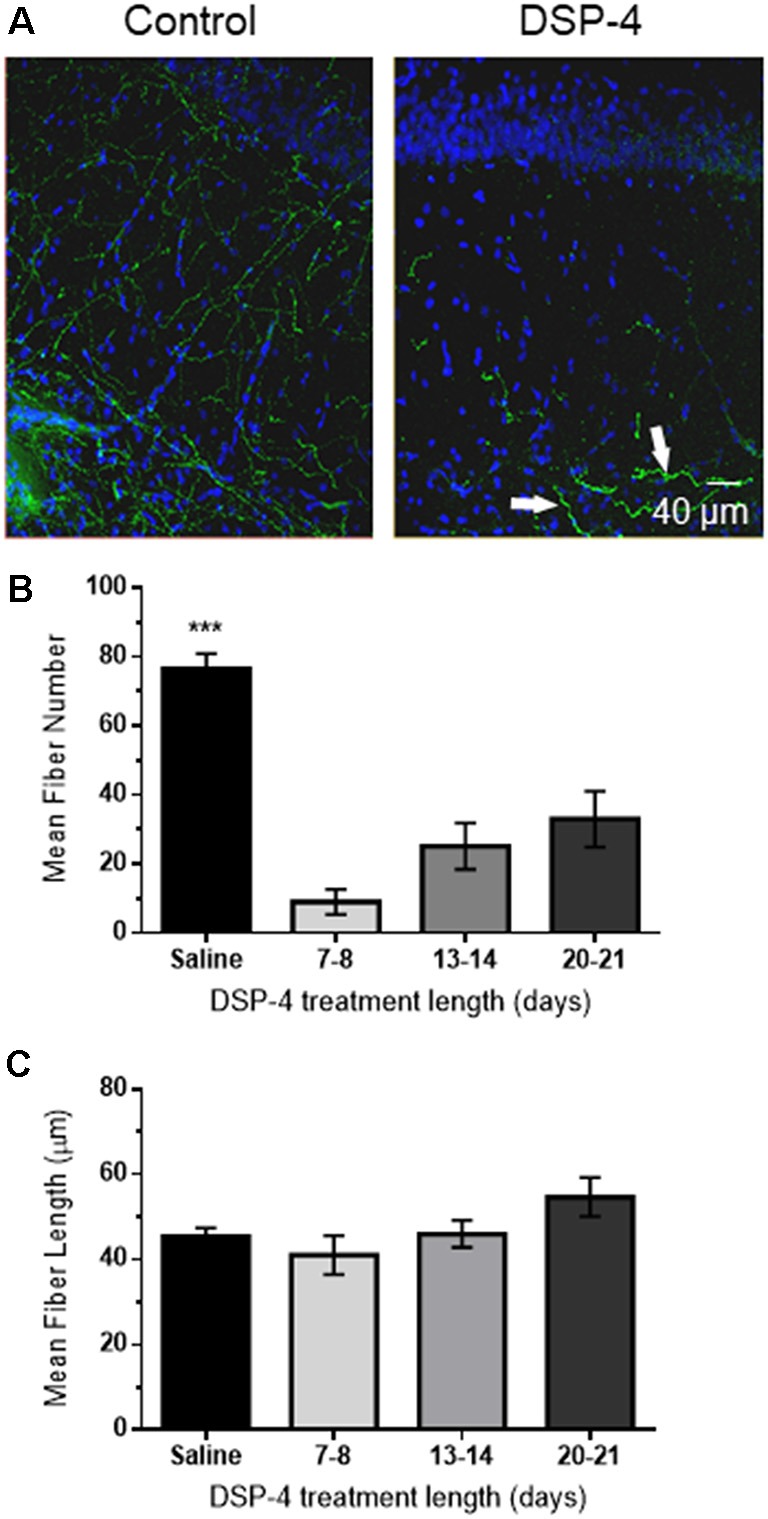
DSP-4 treatment causes significant NE degeneration in CA1 of hippocampus. (A) Anti-DβH (green) and DAPI (blue) hippocampal staining of NE fibers in area CA1 s. radiatum from a saline-treated (control) animal or following DSP-4 treatment (scale bar: 40 μm). Arrows denote thicker, knobby appearance of some remaining NE fibers. (B) Mean fiber number in DSP-4 treated animals in CA1 s. radiatum is significantly decreased compared to saline-treated measured 7–21 days post-treatment. (C) Mean NE fiber length is unchanged following DSP-4 treatment. (C) Total NE fiber number is significantly decreased by DSP-4 treatment by ~85% (saline, n = 7; DSP-4, n = 19).